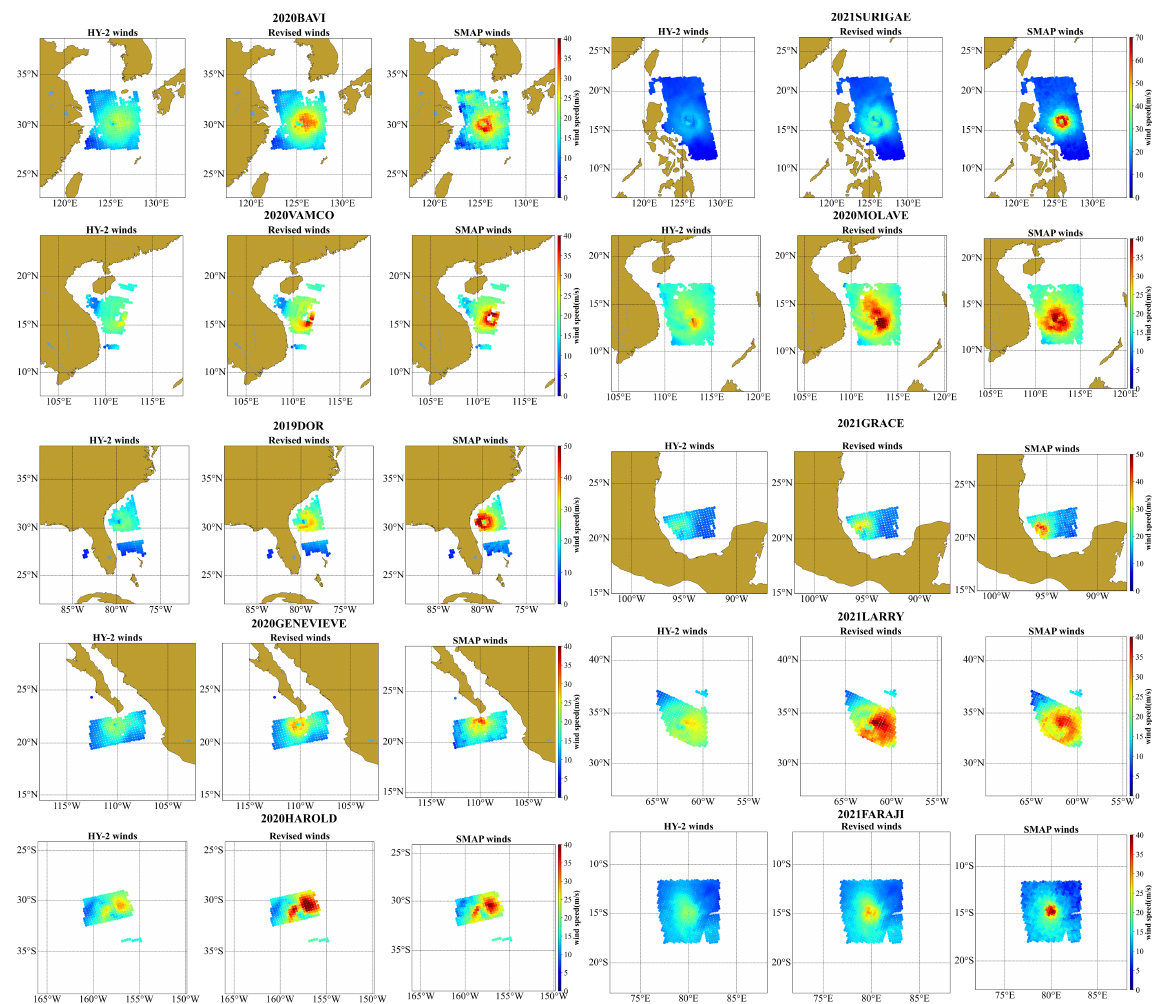
Figure 8. The wind field distribution before and after revision by the BP-NN algorithm in the tropical cyclone